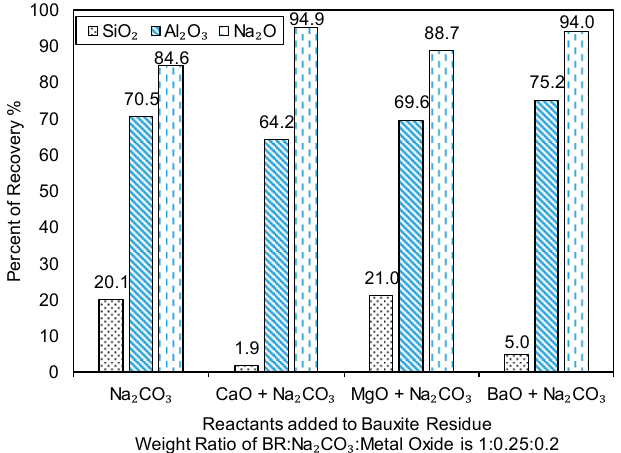
Figure 21. Results of experimental recovery of Al 2 O 3 , SiO 2 , and Na 2 O with CaO, MgO and BaO added with 50% excess soda, compared to only 50% excess soda, Na 2 CO 3 , at 900 °C for 2 h. A simplified mass balance of the laboratory scale experiment of optimised recovery at 50% excess soda (soda only) and stoichiometric carbon with 50% excess soda (carbon + soda) is presented in the flowchart (Figure 22) and mass balance (Table 3). The recovery of an optimised sintering process will be be 70% and 75% for aluminum (0.2 g Al/L) and 85% and 83% for sodium (~1 g Na/L) for soda only system and carbon with soda system respectively. The recovery of silica is kept below 20% (~0.02 g Si/L) when washed with solid-to-liquid ratio of 1:66. The leaching optimisation of the system is recommended to be investigated following this research. The proportion of leached residue to sinter product is 68.2% and 58% for soda only system and carbon with soda system respectively. The latter will experience higher gaseous carbon monoxide/dioxide losses and reduce Fe 2 O 3 in residue into FeO or Fe 3 O 4 , and therefore decreasing load for downstream processing. Figure 22. Total proposed flowsheet for the recovery of aluminum and sodium.